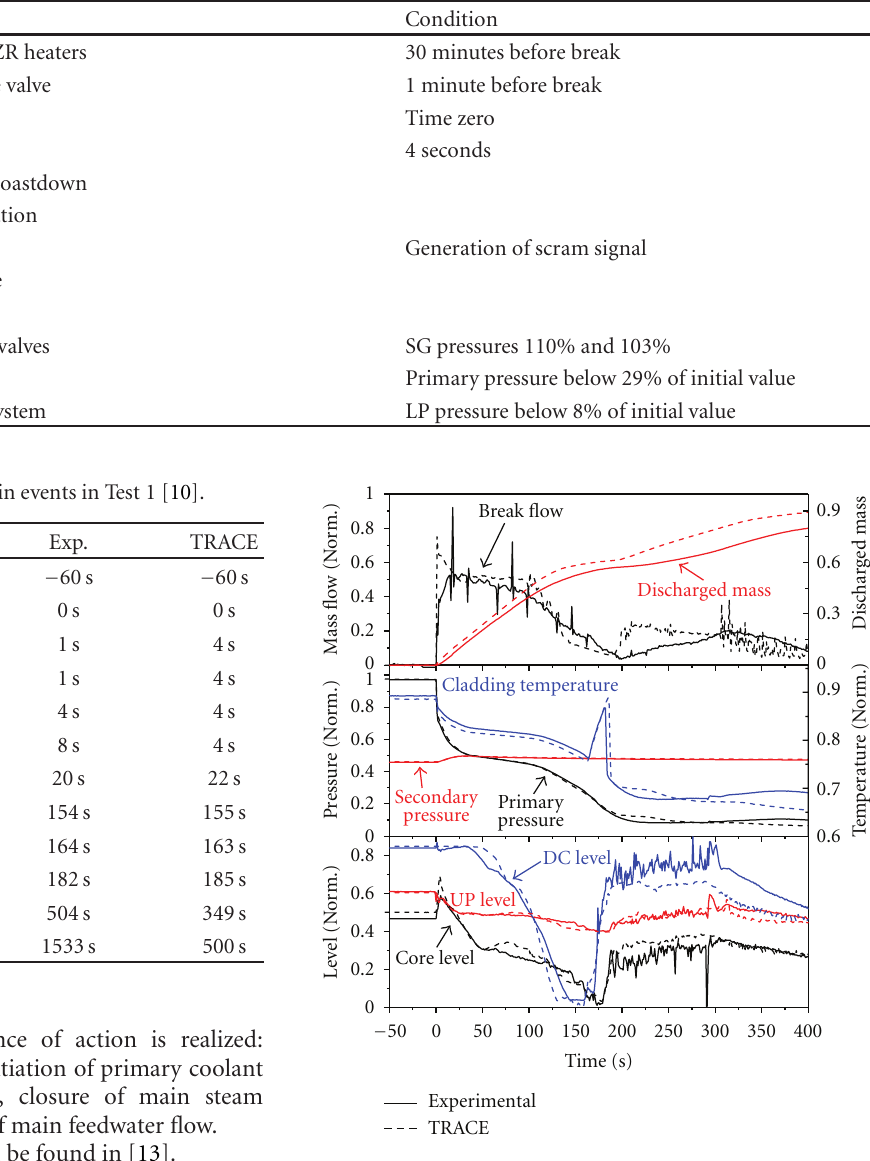
Figure 4: TRACE results for Test 1. From top to bottom: (1) break flow and integrated discharged mass, (2) primary and secondary pressure along with the maximum cladding temperature, and (3) RPV water levels.